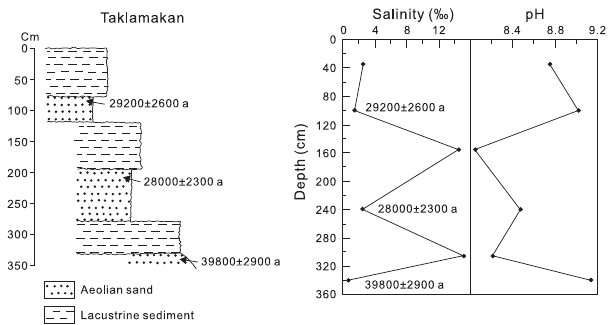
Figure 9. Sequential variations in soluble salt contents (salinity and pH) of the Tumiya-II section in the Taklamakan